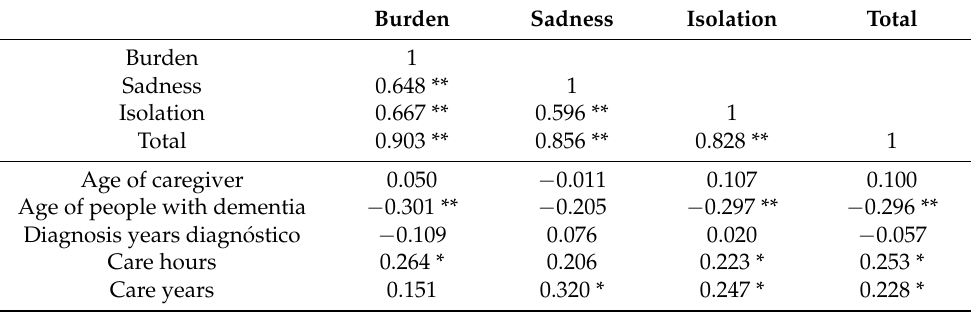
Table 4. Correlation between the dimensions of the anticipatory grief inventory and sociodemo- graphic variables (patient’s age, duration of illness and caring time). Burden Sadness Isolation Total Burden